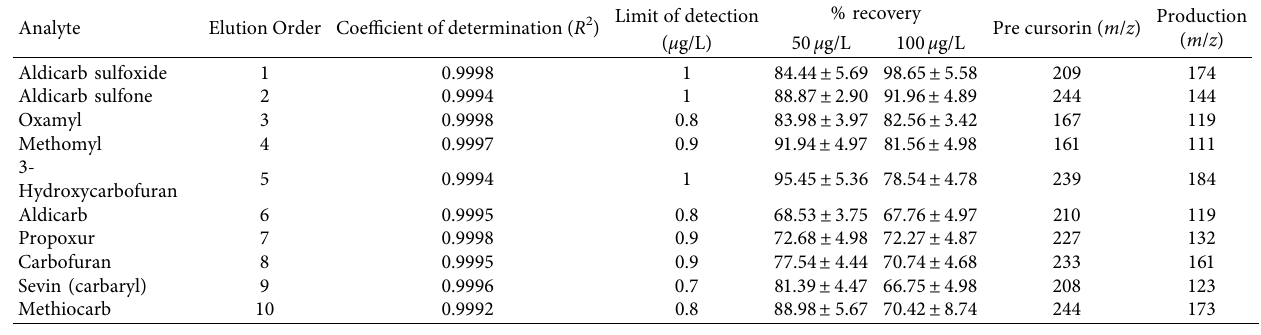
Table 2: The elution order, coefficient of determination ( R 2 ) values, limit of detection, recovery rate, precursor ion ( m / z ), and product ion ( m / z ) of CB